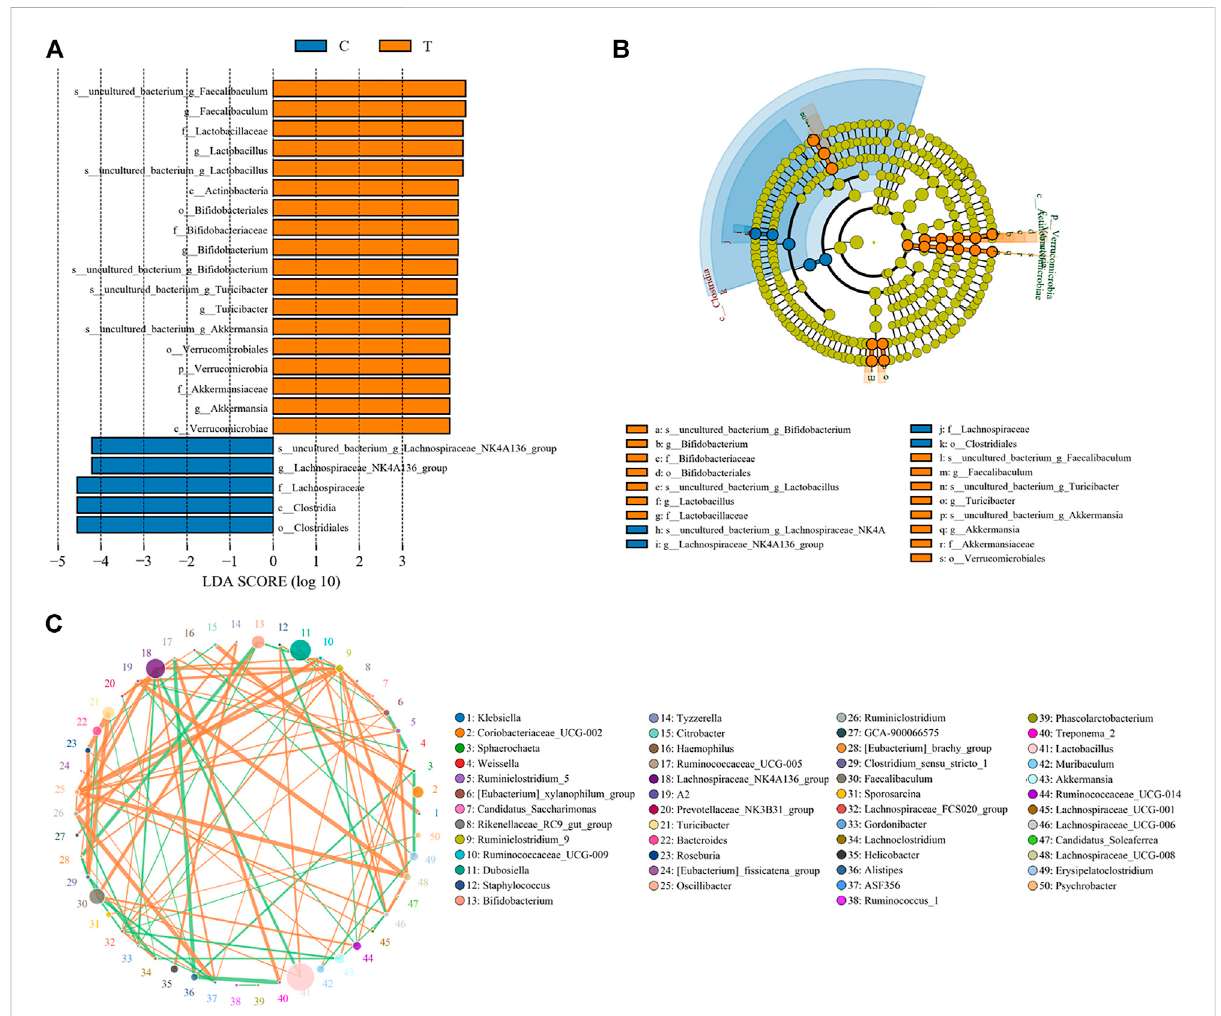
FIGURE 8 Signi fi cant difference analysis. (A) Value distribution histogram of line discriminant analysis effect size. (B) Species annotation was visualized using KRONA. (C) Species network at the genus